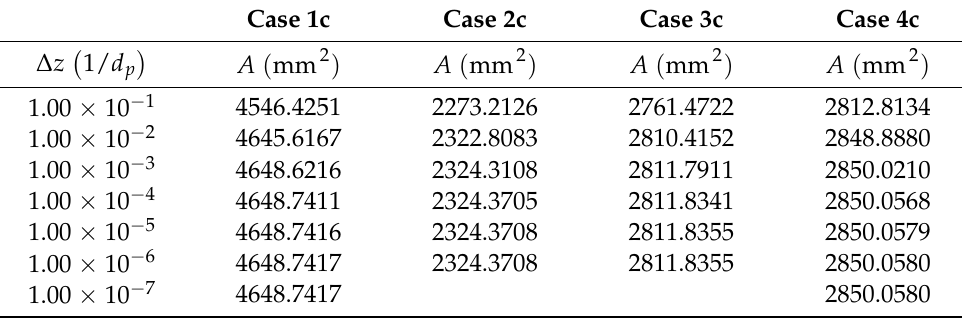
Table 3. Convergence analysis for Equation (8)